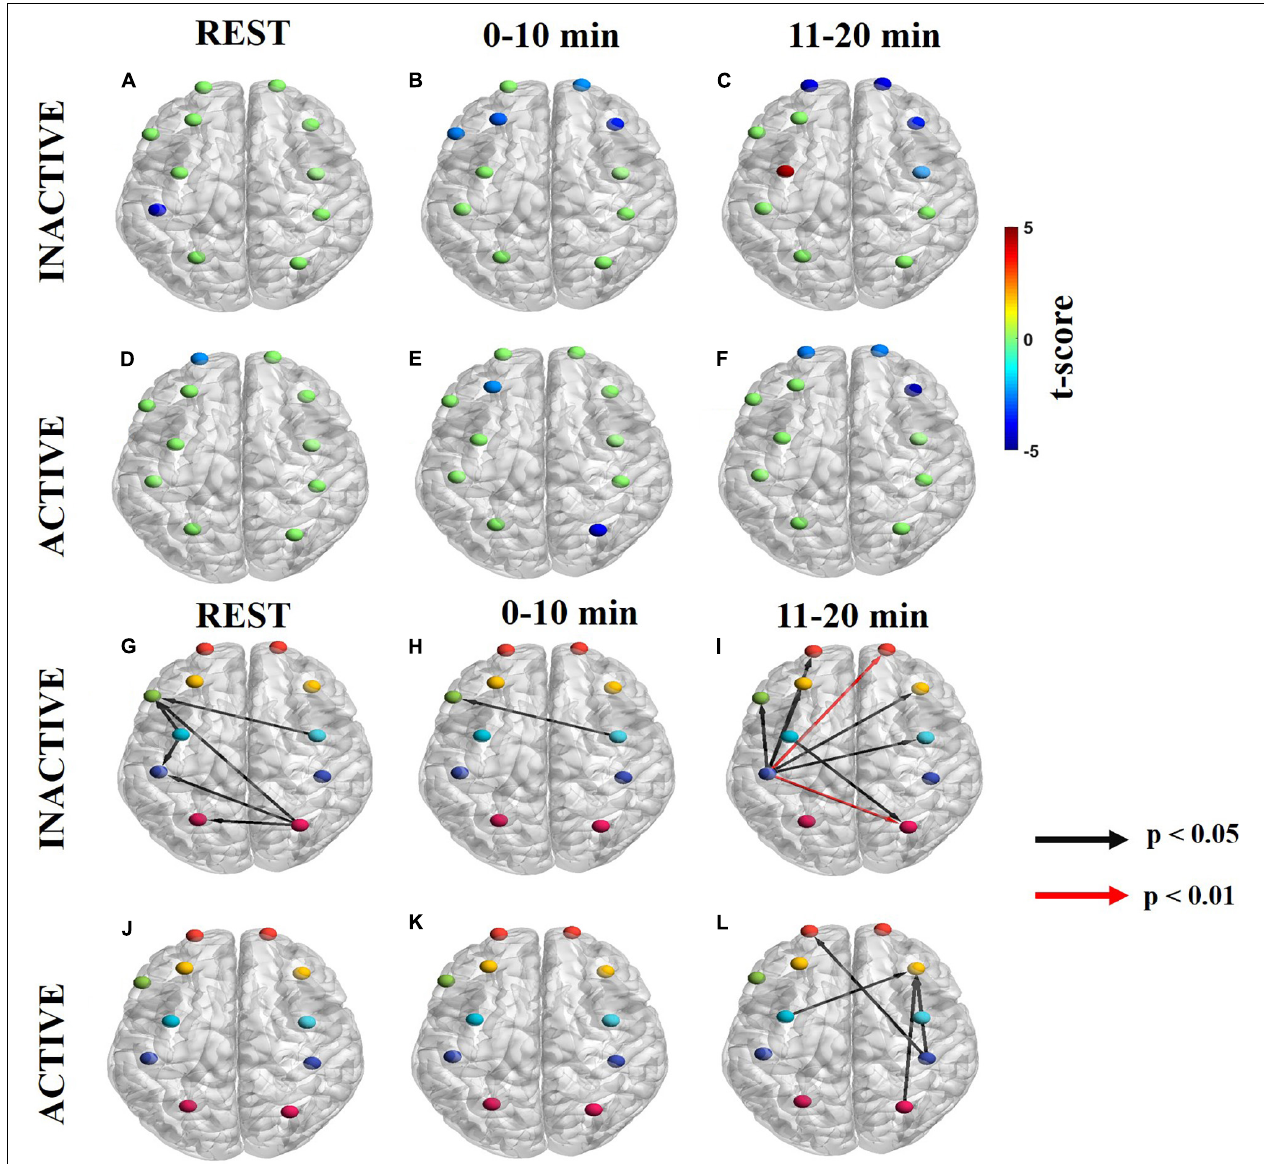
FIGURE 3 | Significant dPTE and DC in the endogenic frequency band for inactive and active subjects during the handgrip task for (cid:49) HbO. Directed PTE t -values for each ROI as a color-coded map for inactive subjects (A–C) and active subjects (D–F) . Hot (yellow-reds) and cold (light blue-dark blue) colors indicate information outflow and inflow, respectively. Arrows indicate statistically significant information flow between functional regions for inactive (G–I) and active subjects (J–L) . Black arrows ( p < 0.05); Red arrows ( p < 0.01). Eleven regions of interest (ROIs) were mapped: left and right frontopolar (lFP; rFP) (red), left and right pre-frontal cortex (lDLPFC; rDLPFC) (yellow), Broca’s area (green), left and right pre-motor cortex (lPMC; rPMC) (light blue), left and right primary motor and sensory cortical (lM1/S1; rM1/S1) areas (purple), and left and right sensory association cortex (lSAC; rSAC) (pink).